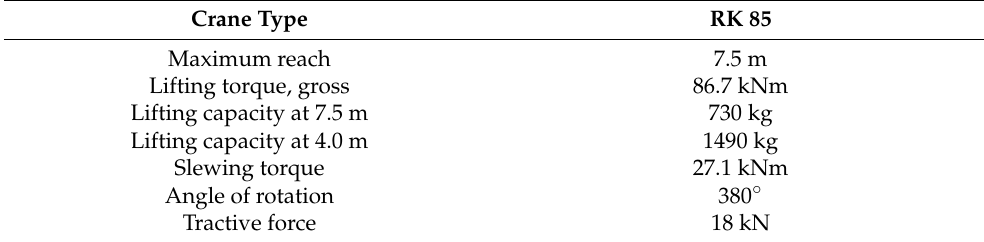
Figure 1. Rottne-F10-based forwarder simulator used in the study. Table 1. Specifications of the Rottne RK 85 crane.